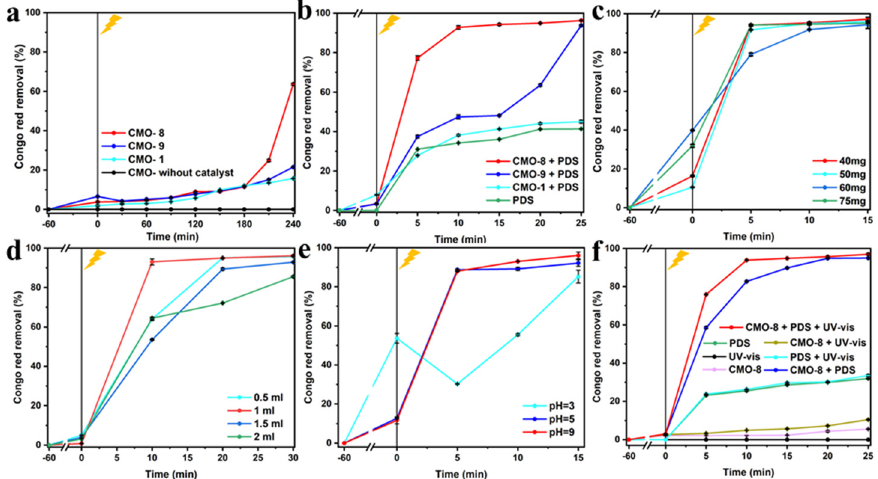
Figure 8. Degradation of CR of ( a ) CMO-8, CMO-9, CMO-1; ( b ) CMO-8, CMO-9, CMO-1 + PDS; ( c ) Effect of catalyst loading; ( d ) Effect of PDS concentration; ( e ) Effect of pH; ( f ) Degradation of CR in different conditions. The error bars represent the standard deviation (n = 3).